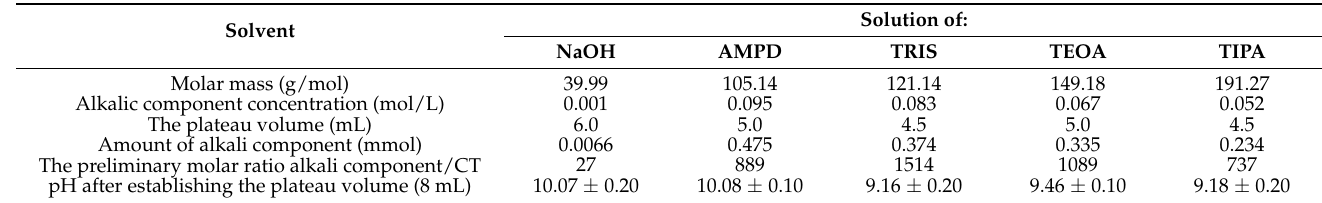
Table 2. The results of the pilot study of the solubility of 5 mg of CT, i.e., 1.68 · 10 − 5 mol, in the alkaline solutions of NaOH, AMPD, TRIS, TEOA, and TIPA.